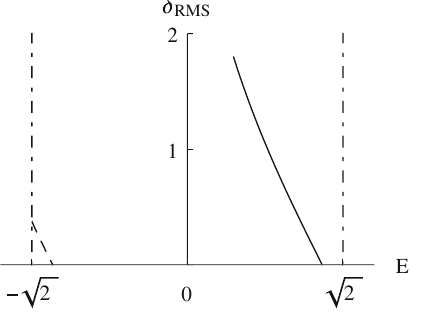
Fig. 9 The back-reaction of the fermion on the soliton, δ RMS , as a function of φ 0 and the fermionic bound energy E . Solid and dashed curves show the back-reaction corresponding to the positive and nega-